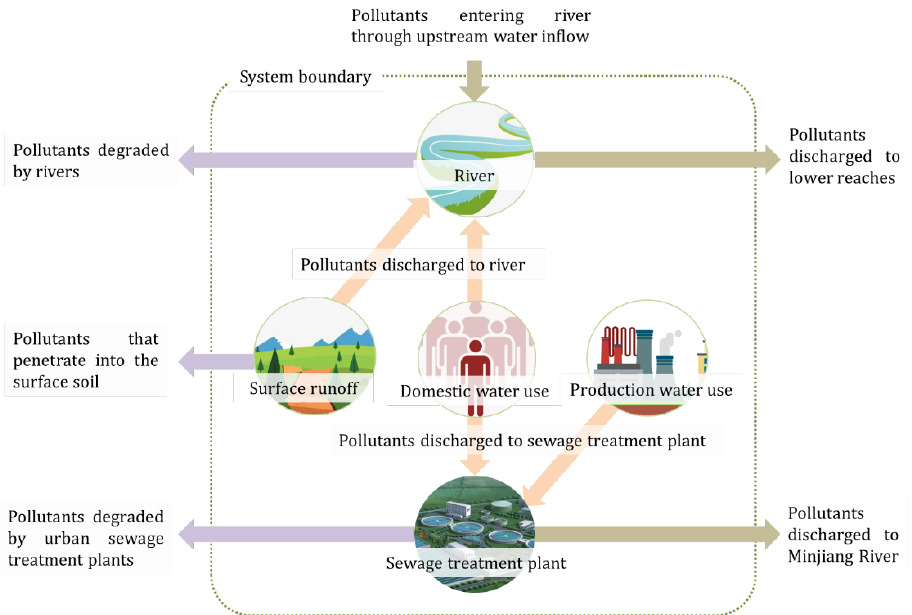
Figure 2. Sketch map of the process flow diagram for the water pollutant metabolism in sub-basin in Fuzhou.